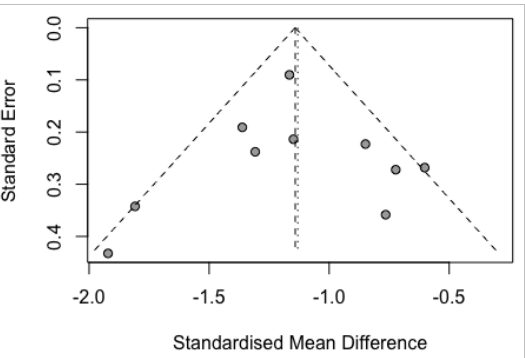
Figure A8. The studies are still well balanced on either side of the effect estimates. So, the funnel plot does not reveal an obvious presence of publication or other bias for HC versus MCI_AD.